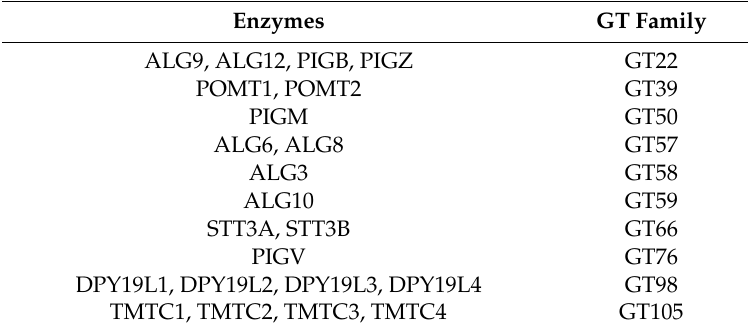
Table 1. Assignment of human glycosyltransferases that uses dolichol linked substrate to CAZy glycosyltransferase